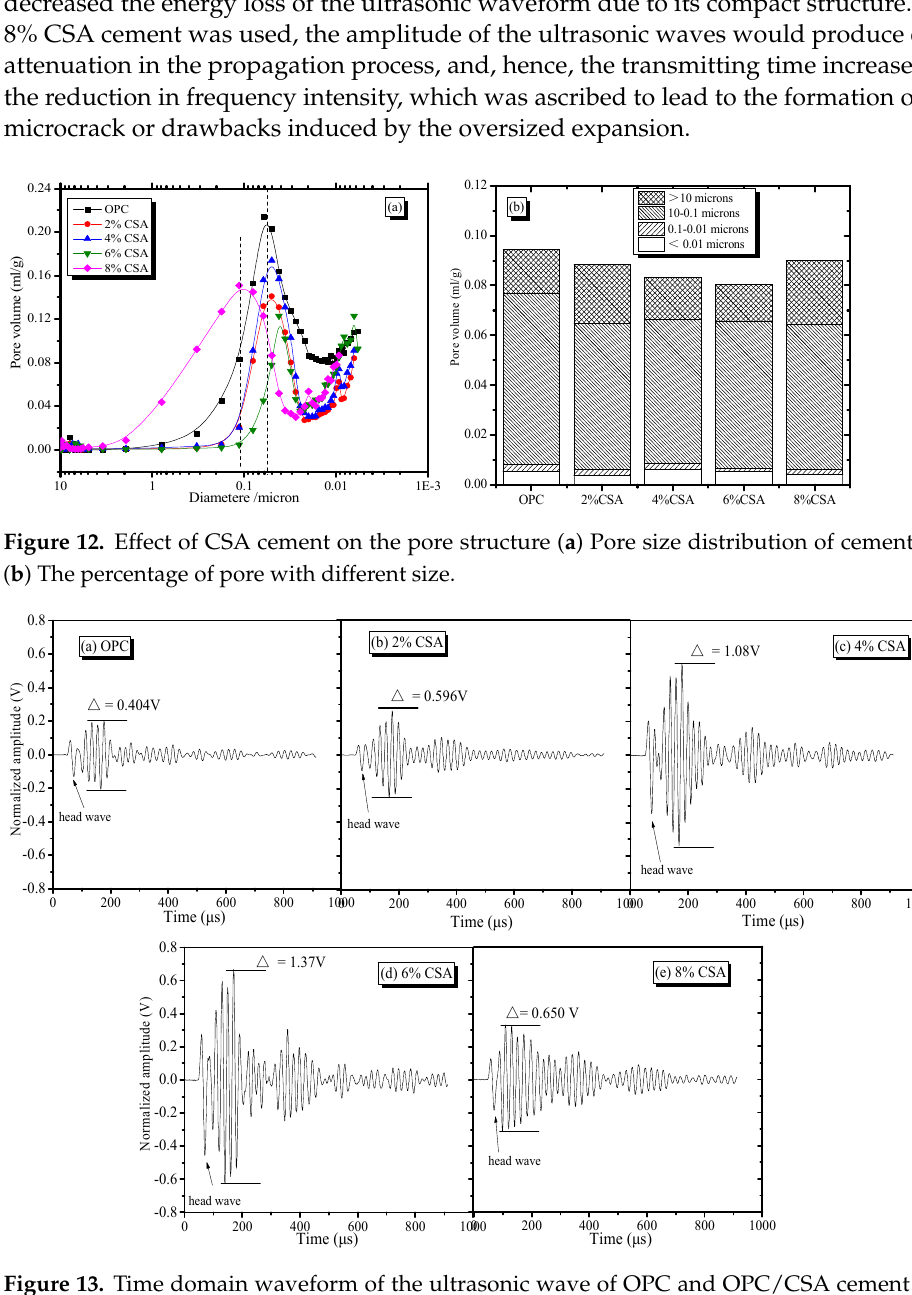
Figure 12. Effect of CSA cement on the pore structure ( a ) Pore size distribution of cement pastes, ( b ) The percentage of pore with different size.